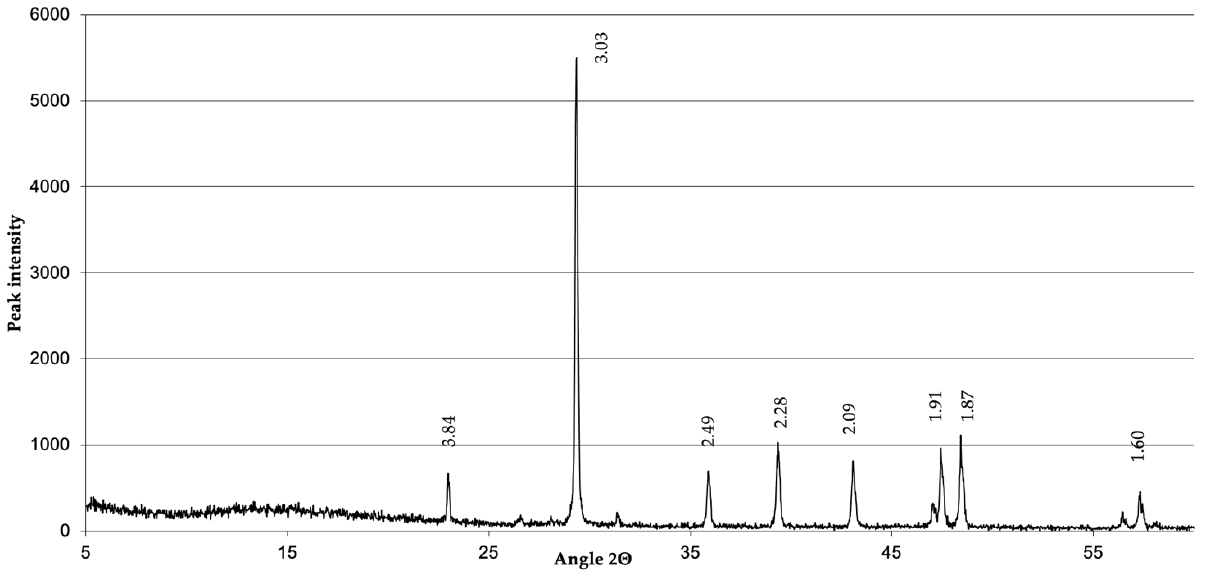
Figure 11. X-ray diffraction pattern of chalk-like limestone sampled near the Anakopia fortress. The intensity of the main peak of calcite (angle 2Θ ~ 29.4°), a higher crystallinity